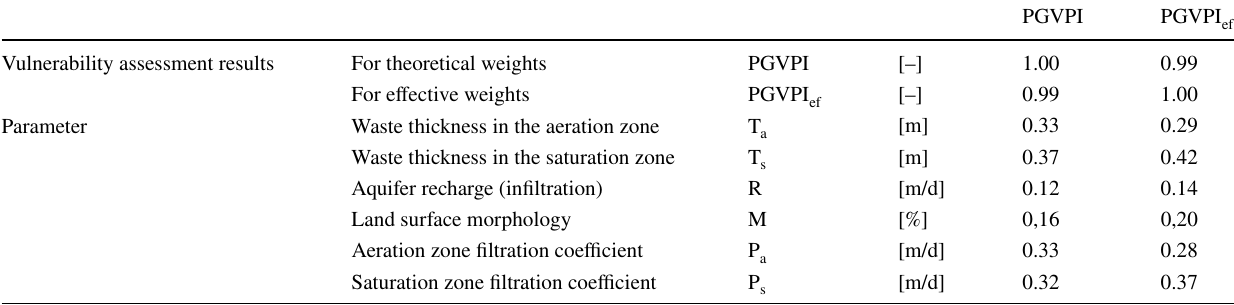
Table 6 Pearson’s correlation coefficient for all selected parameters indicated in the method of assessing groundwater vulnerability to